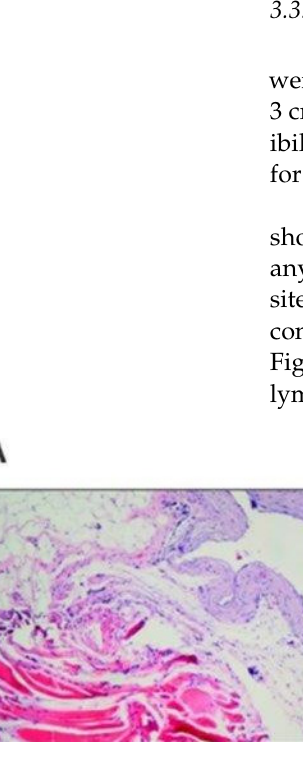
Figure 3. Microscopically assessed image of the heart muscle obtained from implanted animals: ( A ) 100× magnification (scale bar 100 µm), hematoxylin–eosin staining magnification; ( B ) 100× magnifi- cation (scale bar 100 µm), Masson’s staining.